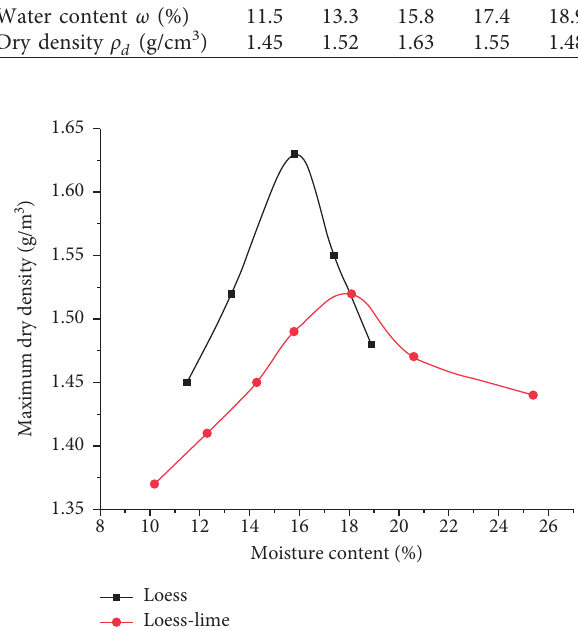
Table 1: Loess compaction test results.